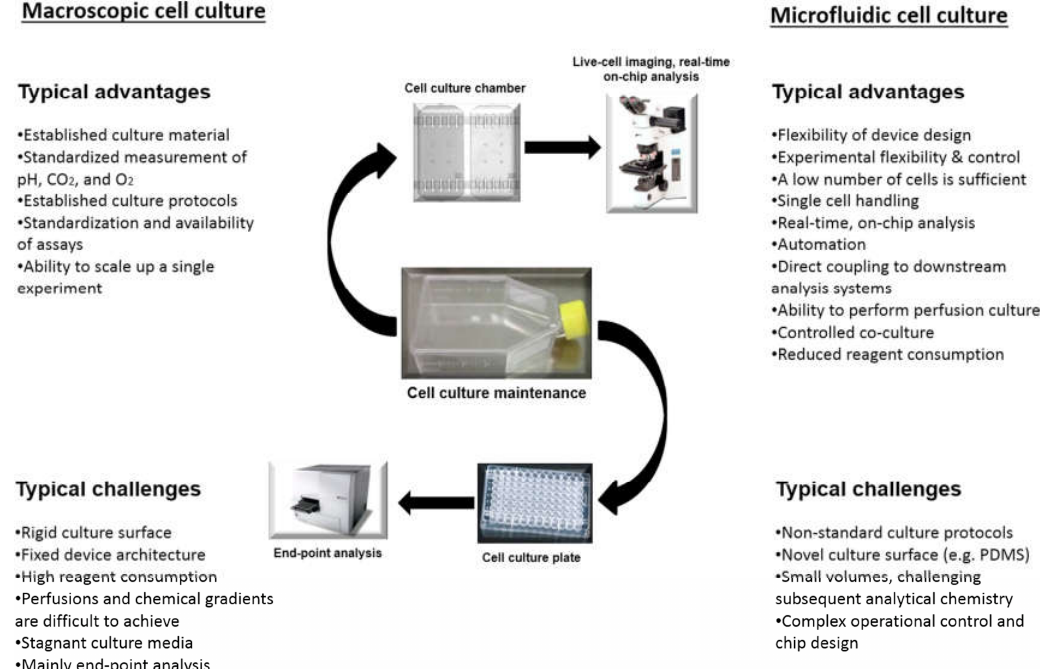
Figure 2. Overview of the advantages and challenges of both macroscopic and microfluidic cell culture. Reproduced from Halldorsson et al. [12], with permission from Elsevier.